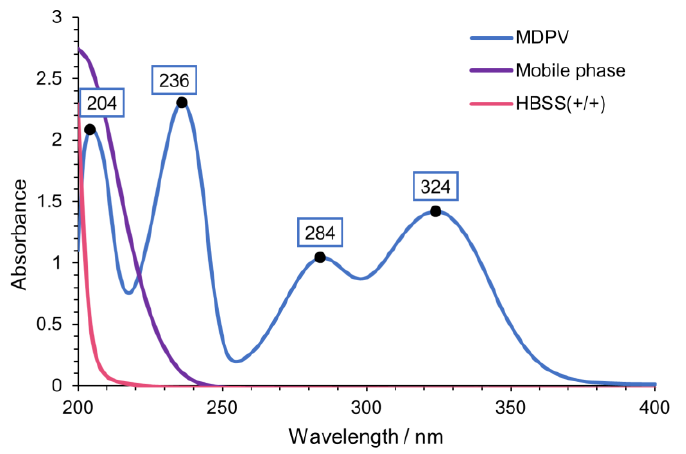
Figure 3. UV spectra of MDPV [100 µ M in HBSS (+/+)], mobile phase [25 mM NH 4 CH 3 CO 2 : CH 3 CN: HCOOH (75:25:0.1 v / v / v )] and